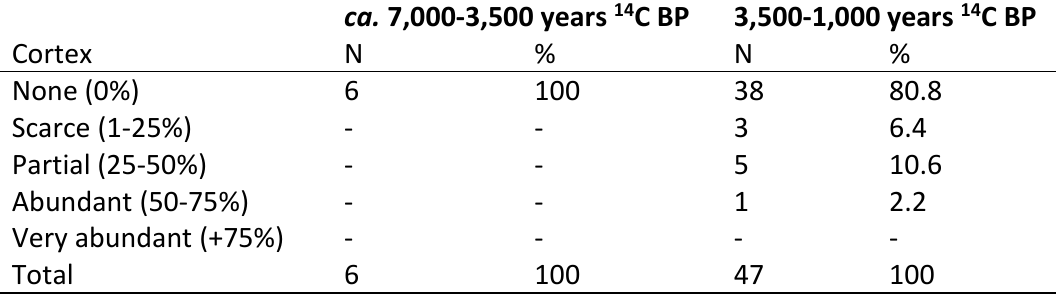
Table 7. Amount of cortex in complete flakes by